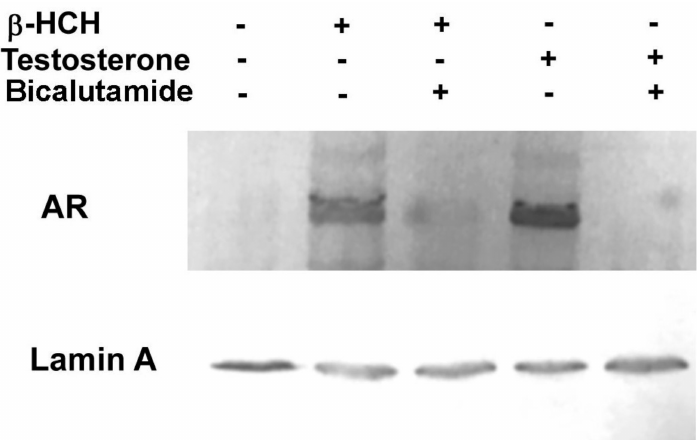
Figure 3. AR nuclear localization detected by Western blot analysis. Nuclear protein extracts were obtained from LNCaP stimulated for 4 h with 10 µ M β -HCH or 30 nM testosterone, either pretreated or not with 120 nM bicalutamide incubation overnight. AR is found localized in the cellular nuclear fraction of samples treated with β -HCH and testosterone, whereas the band is barely detectable when cells are preincubated in the presence of the AR inhibitor bicalutamide. Lamin A was used as a specific nuclear marker and normalization protein. The experiment was repeated three times and a representative blot is reported.